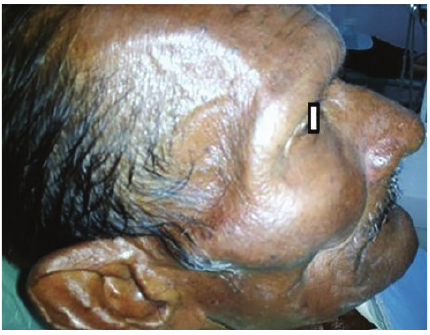
Figure 4: Profile view showing facial atrophy with loss of muscle and